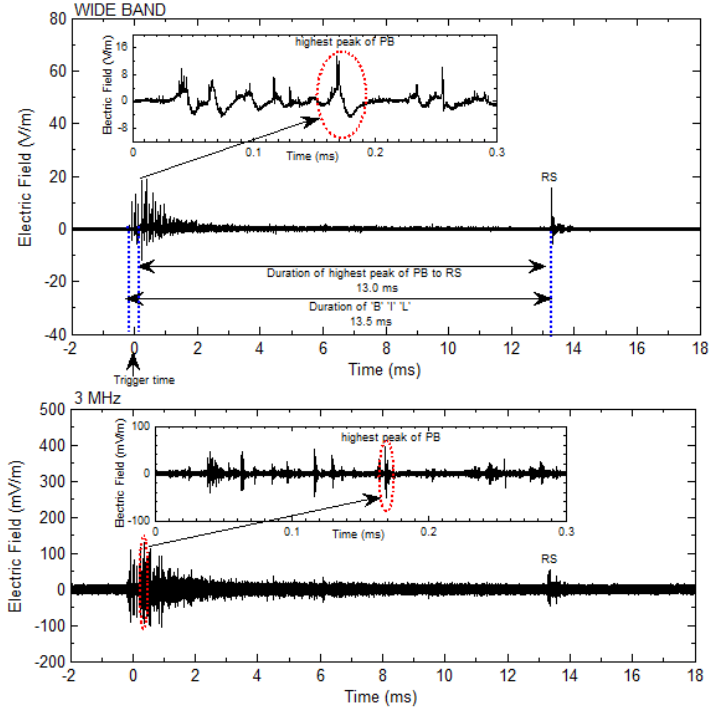
Figure 3. A sample of flashes with higher PB amplitudes compared to the following RS recorded on 19/07/2014 at 15:58:26:656472 located at a distance of 34.89 km from the measuring station where the strike location was at (60.10540°N, 17.32080°E). (top figure) A wideband record of the flash showing the PB together with the first RS. (bottom figure) the 3 MHz record of the same flash as in the top figure. Note that the highest peak of the PB pulse trains of wideband and 3 MHz signals is shown in the inset of the respective figures. Table 3. Preliminary breakdown (PB) to return stroke (RS) electric field peak